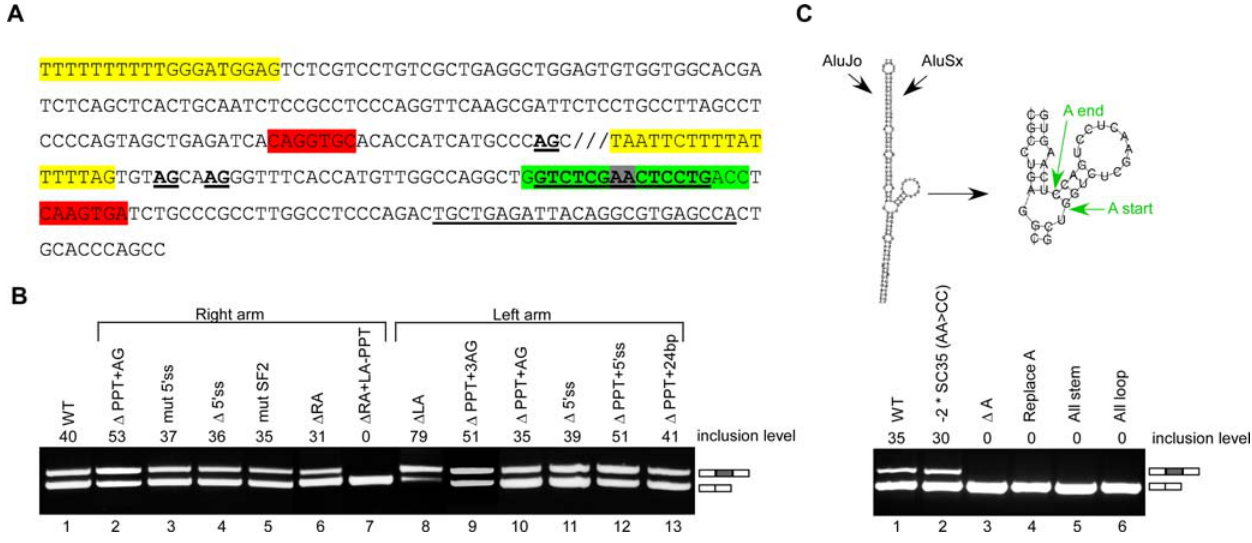
Figure 5. The effect of Alu 2 on the alternative exon. (A) The sequence of the antisense Alu 2. Mutated putative 5 9 ss is shown in red. A sequence of 24 nucleotides that was deleted is underlined. Three putative 3 9 ss that were mutated are in bold and underlined. In yellow are the right and left PPT regions with the downstream AG that were deleted. The green sequence is a stem and loop region of 18 nucleotides that was examined as shown in panel C (referred as ‘A’ region). Underlined in that region are two overlapping SC35 potential binding sites (the gray in the middle indicates the overlap region). (B) The indicated wt and mutant plasmids were transfected into 293T cells, total RNA was extracted, and splicing products were separated on a 2% agarose gel after RT-PCR analysis. Lane 1, splicing products of wt RABL5 minigene. Lanes 2–13, splicing products of the indicated mutants. The two mRNA isoforms are shown on the right. Numbers on top of the gel indicate percentage of exon inclusion, as determined using ImageJ software. (C) The upper part illustrates the putative secondary structure formed by Alu Jo and Alu Sx, as predicted using the Vienna secondary structure web site (http://www.tbi.univie.ac.at/RNA). The green arrows in the right panel indicate the start and end positions of the stem and loop structure, marked as ‘A’. The lower part shows the effect of the wt and mutant plasmids that were analyzed, as in panel B. Lane 1, wilt type. Lane 2, elimination of the two SC35 putative binding sites by mutating their overlapping sequence (AA were mutated to CC). Lane 3, deletion of the entire stem-loop ‘A’ sequence. Lane 4, replacement of the ‘A’ sequence by a random sequence lacking putative splicing binding sites. Lane 5, replacement of the loop sequence by a perfect complementary sequence, so that the ‘A’ element is entirely in a stem structure. Lane 6, disruption of the stem part of ‘A’, so that ‘A’ is entirely in a loop